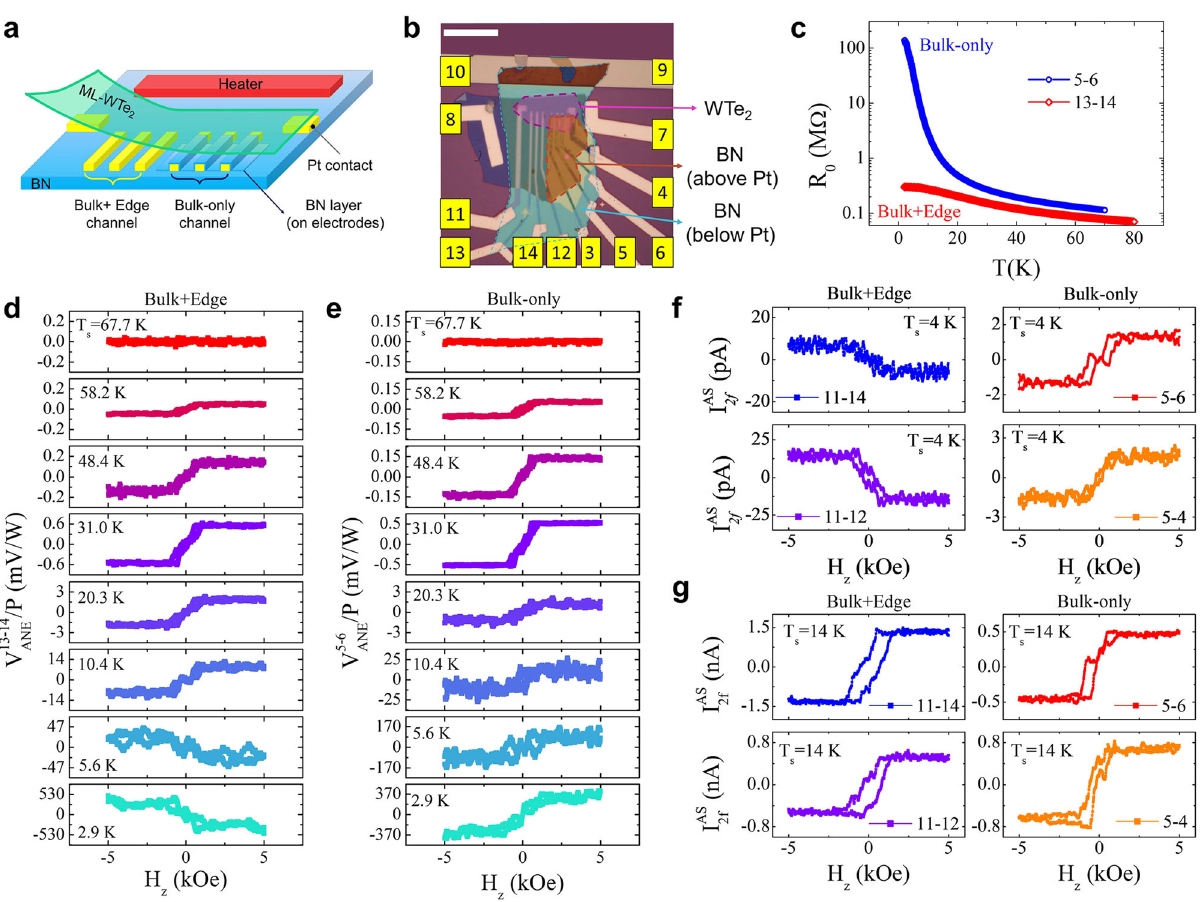
Fig.3|AnomalousNernsteffectandanomalousHalleffectfromedgeandbulk channels of ML-WTe 2 /Cr 2 Ge 2 Te 6 . a Schematic diagram of device structure. Electrodes on the left side probe combined edge and bulk signal of ML-WTe 2 , and those on the right side are partly covered with BN to prevent edge contact with ML-WTe 2 , thus only detect the bulk ANE. b Optical image of device D7 prior to transfer of ML-WTe 2 /Cr 2 Ge 2 Te 6 composite layer. The ML-WTe 2 fl ake is indicated by the purple dashed polygon. Electrodes from 11 to14 probe the ANE signal from both edge and bulk, and electrodes from 3 to 6 probe the bulk-only ANE signal. The scale bar is 10 μ m . c Temperature dependence of